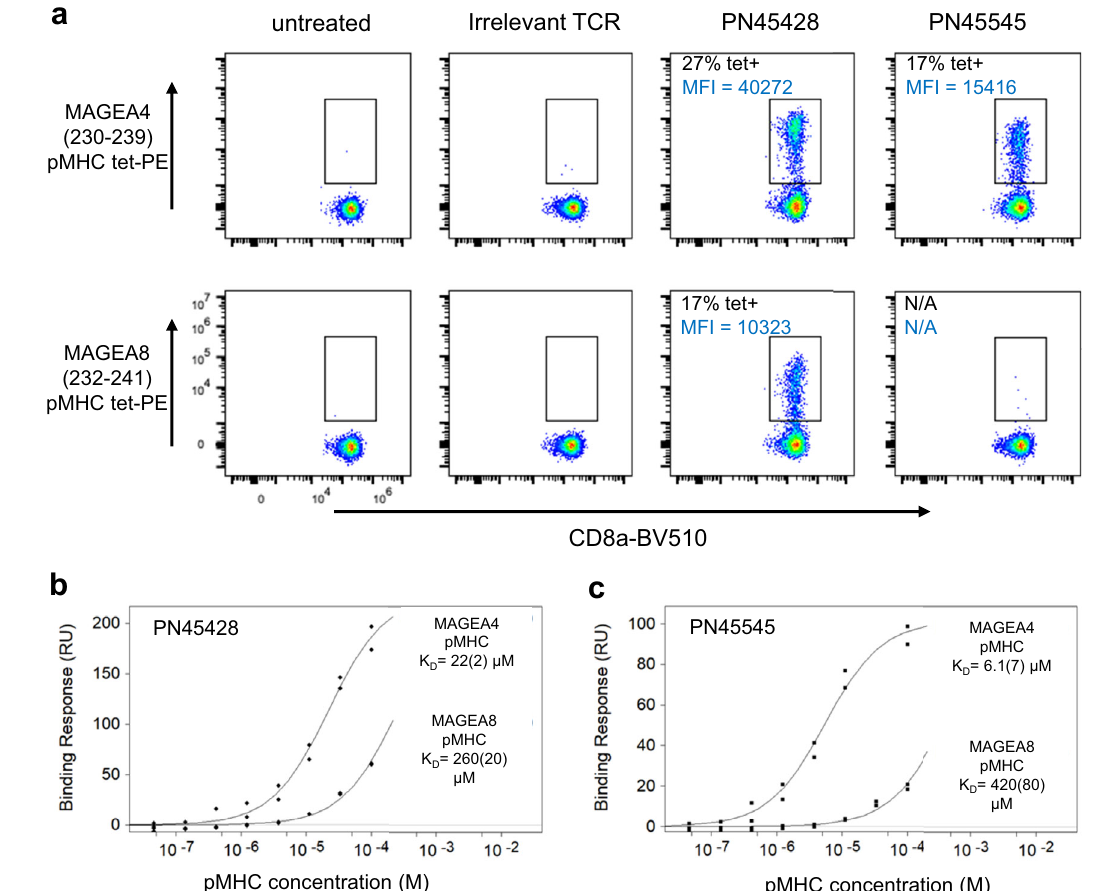
Fig. 4 | Preferential binding of TCRs to MAGEA4 pMHC over MAGEA8 pMHC. a Flow cytometry analysis of pMHC tetramers binding to primary human T cells expressing PN45428 or PN45545 TCRs, gated on live, single CD8+ cells. At least 30,000 live, single cells were acquired for each sample. SPR binding responses of full-length TCR-CD3 reagents against MAGEA4 and MAGEA8 pMHC demonstrate